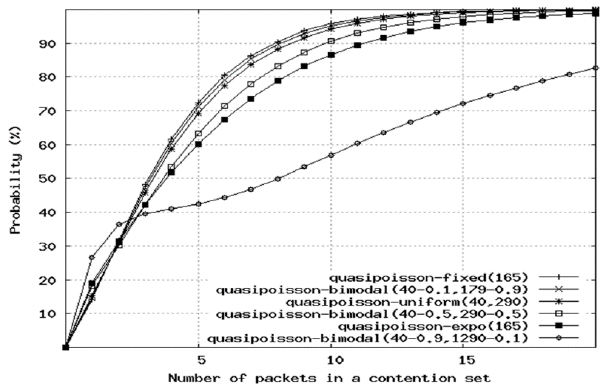
Figure 14. Length of the sequence of mutually overlapping packets (the contention set) for various traffic distributions.